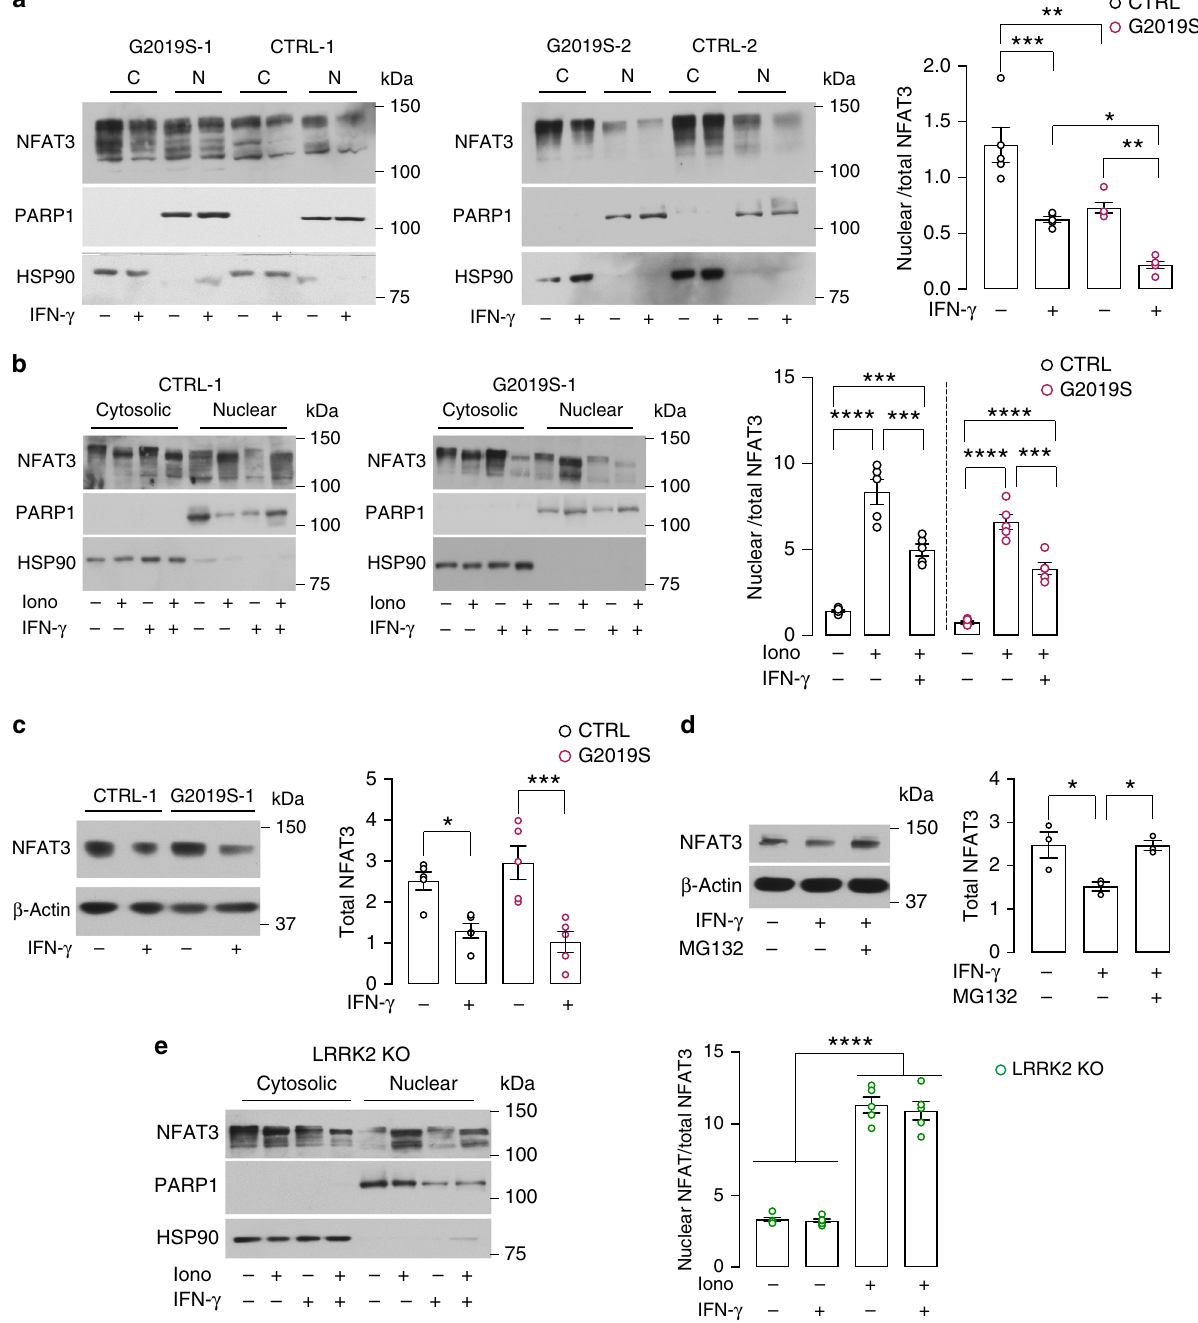
Fig. 3A, B). Next, we transfected HEK NFAT reporter cell lines with LRRK2 wild-type (wt) or LRRK2 G2019S constructs (Supplementary Fig. 3C) and measured NFAT transcriptional activity in response to phorbol 12-myristate 13-acetate (PMA) and ionomycin. We found that overexpression of wt LRRK2 inhibits NFAT-dependent transcriptional activity (Supplementary Fig. 3D). Moreover, NFAT activity was decreased to a greater extent in cells overexpressing LRRK2 G2019S (Supplementary Fig. 3D). PTX treatment effectively rescued the inhibitory effect of wt LRRK2 and LRRK2 G2019S overexpression on NFAT activation, suggesting that microtubule stabilization promotes NFAT nuclear